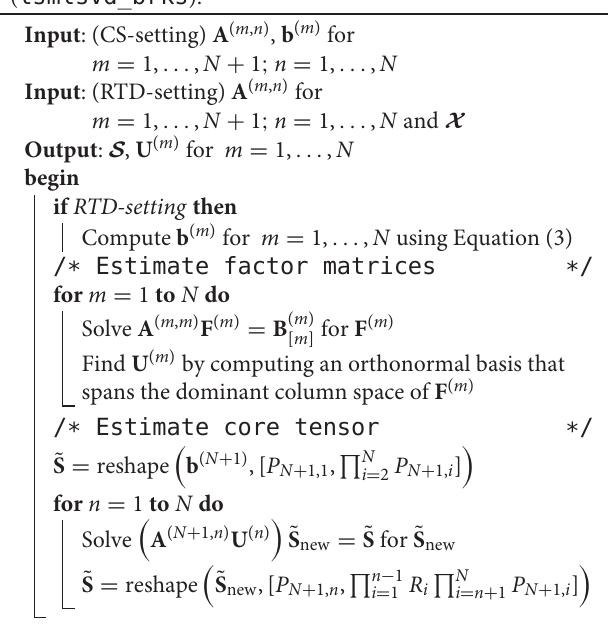
Algorithm 1: MLSVD from a BRKS linear